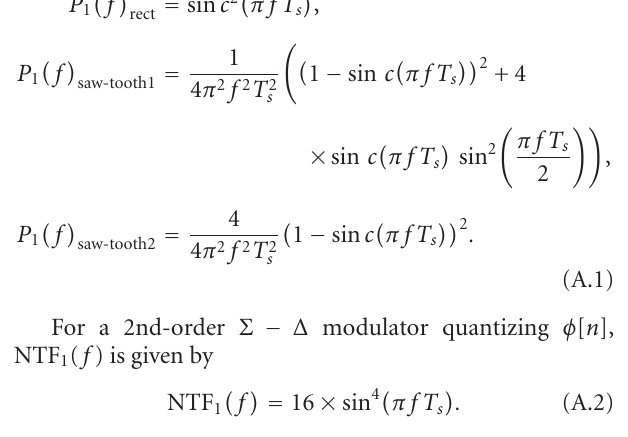
the lse-shaping